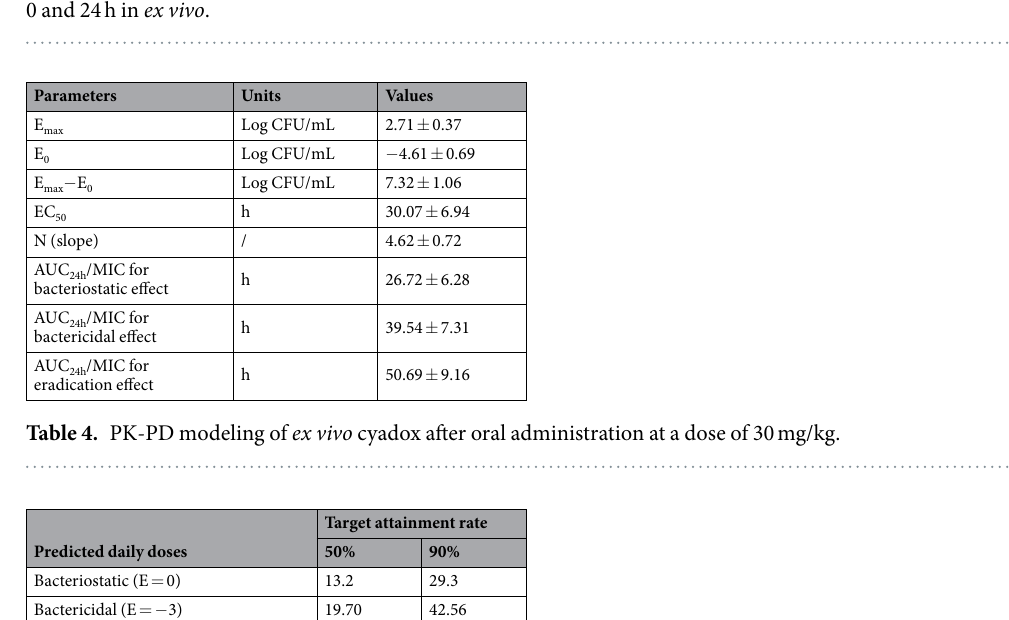
Figure 6. Plots of ex vivo AUC/MIC ratios versus the amount difference of C . perfringens CPFK122995 between 0 and 24 h in ex vivo .